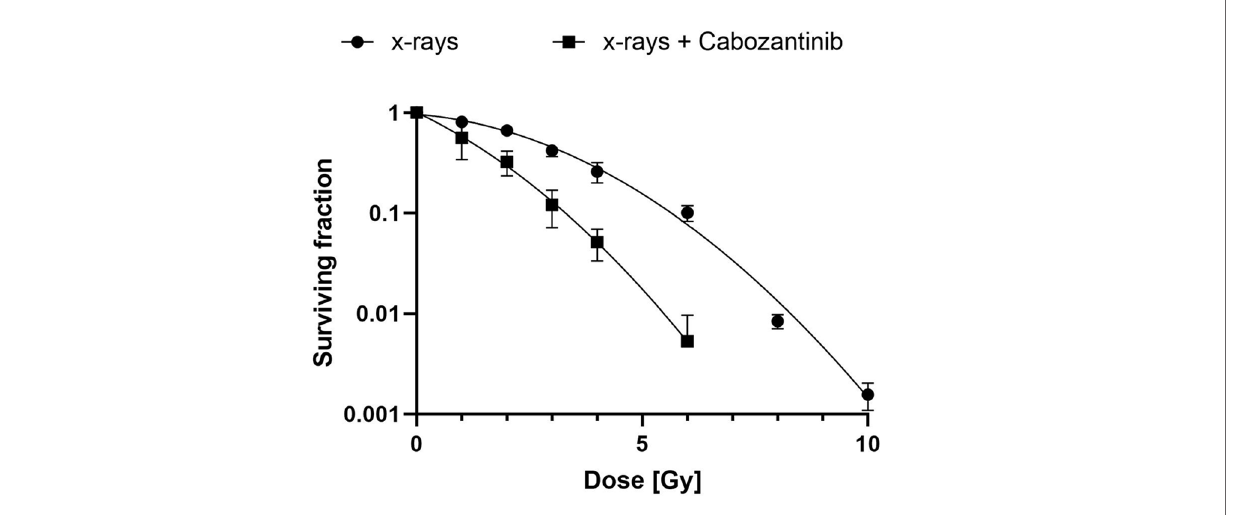
FIGURE 2 | Clonogenic cell survival after exposure to x-rays and Cabozantinib. A colony formation assay was performed as described following exposure to x-rays or x-rays and 2.5 µM of Cabozantinib. Results are derived from two (x-rays + Cabozantinib) or three (x-rays) independent experiments (mean value ± SD). A t-test comparing s -values of a revealed a signi fi cant difference